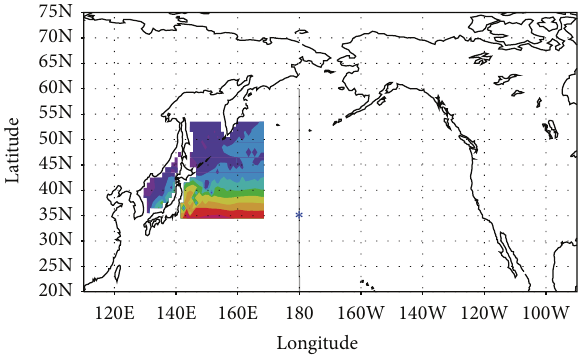
Figure 1: Subsampling region (color) adopted as the result of an adjoint sensitivity analysis [11]. Color shading is the typical temperature pattern at a depth of 300 m in this region. The blue asterisk denotes the point where the remote effect of changes in the subsampled data was evaluated (see Section 3 for details). The representativeness of the vertical structure of the salinity field was assessed along the gray line at 180 ∘ (see Figure